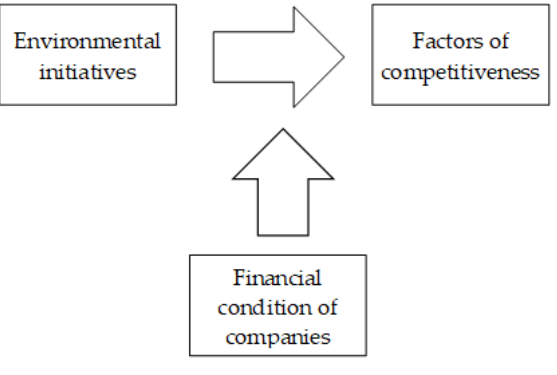
Figure 2. Research